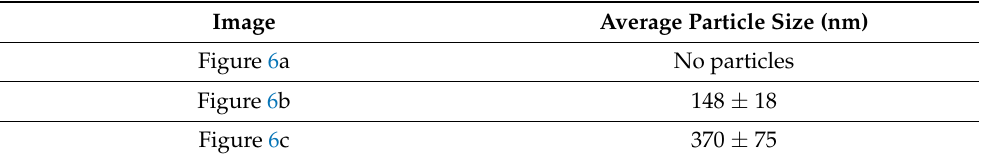
Table 4. Average particle size determined from SEM images of Figure 6: Figure 6a: TEOS:PrTMS; Figure 6b: TEOS:DTMS; and Figure 6c: TEOS:ODTMS at a molar ratio of 5:5. Image Average Particle Size (nm) Figure 6a No particles Figure 6b 148 ± 18 Figure 6c 370 ± 75